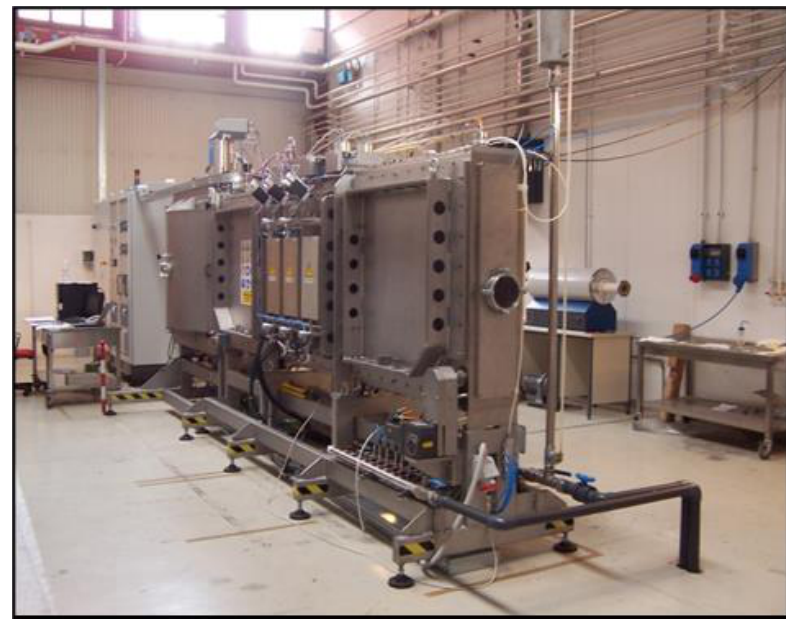
Figure 1. A general view of ENEA-2 sputtering plant.